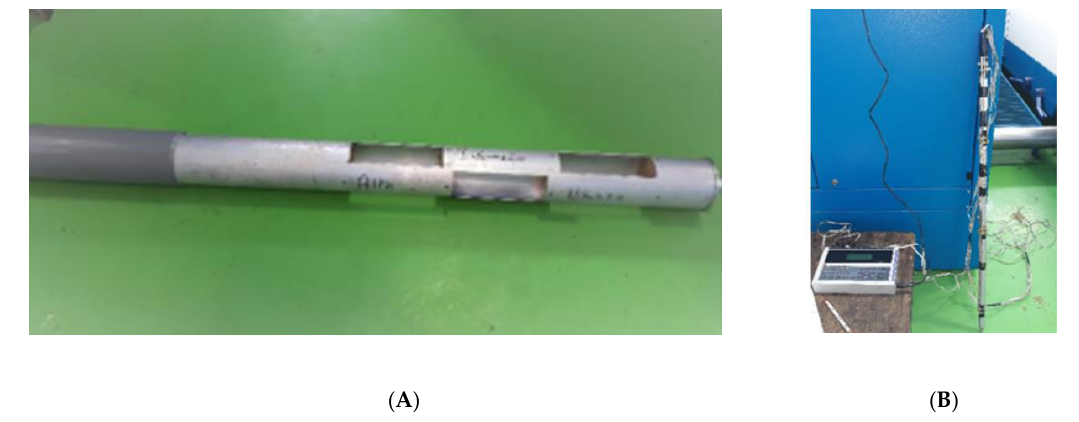
Figure 3. Olive paste sampler and sampling from the malaxer. ( A ) stainless steel bar with probes arranged in three different points and connected ( B ) to the BABUC data acquisition system.